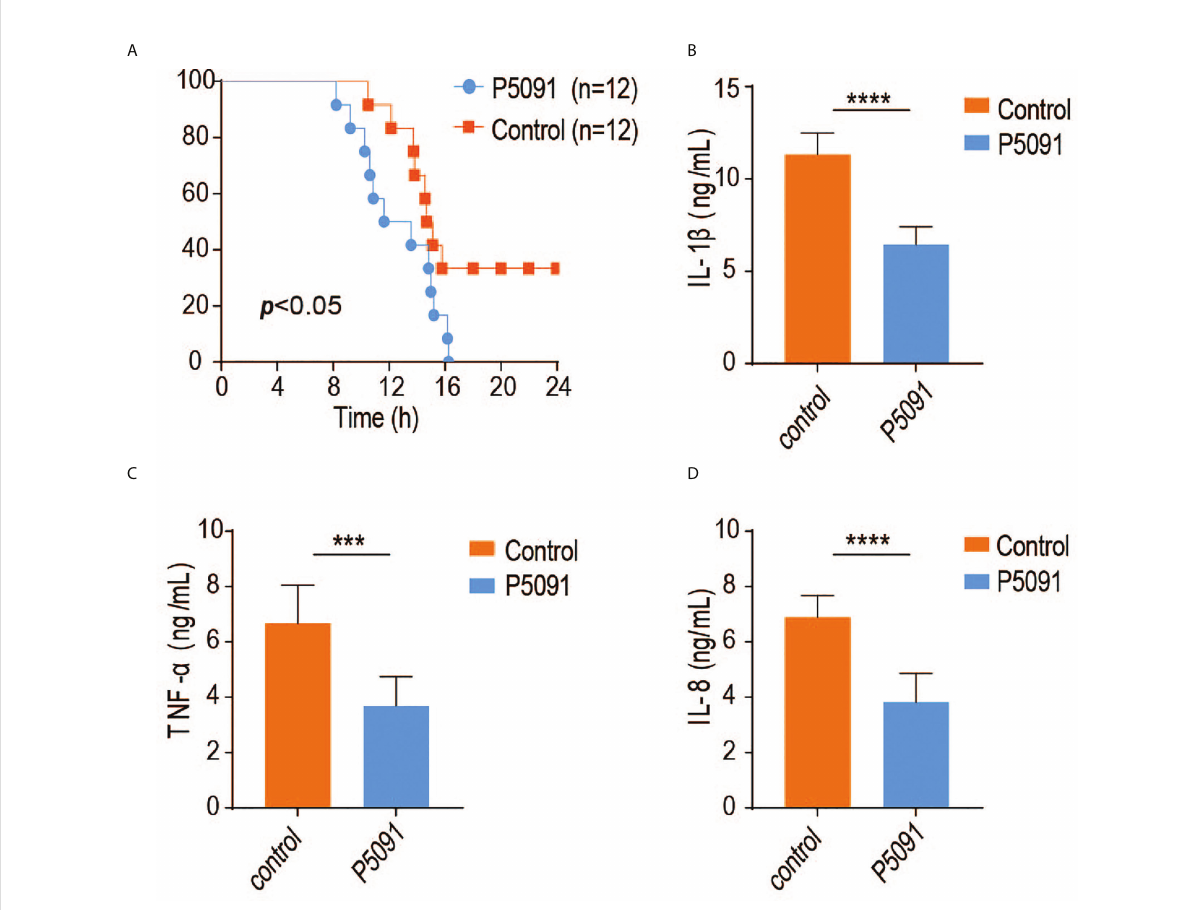
FIGURE 4 Inactivation of USP7 deubiquitination activity leads to attenuated innate immune responses. (A) P5091-treated mice were challenged with Salmonella typhimurium (5×10 8 CFU) and their survival rates monitored for 24 h (n = 12 each group; statistical analysis: Mantel – Cox test). (B – D) ELISA of IL-1 b , IFN- a , and IL-6 in the serum of P5091-treated mice challenged with Salmonella typhimurium for 6 h (n = 7 per group). ***p<0.001;